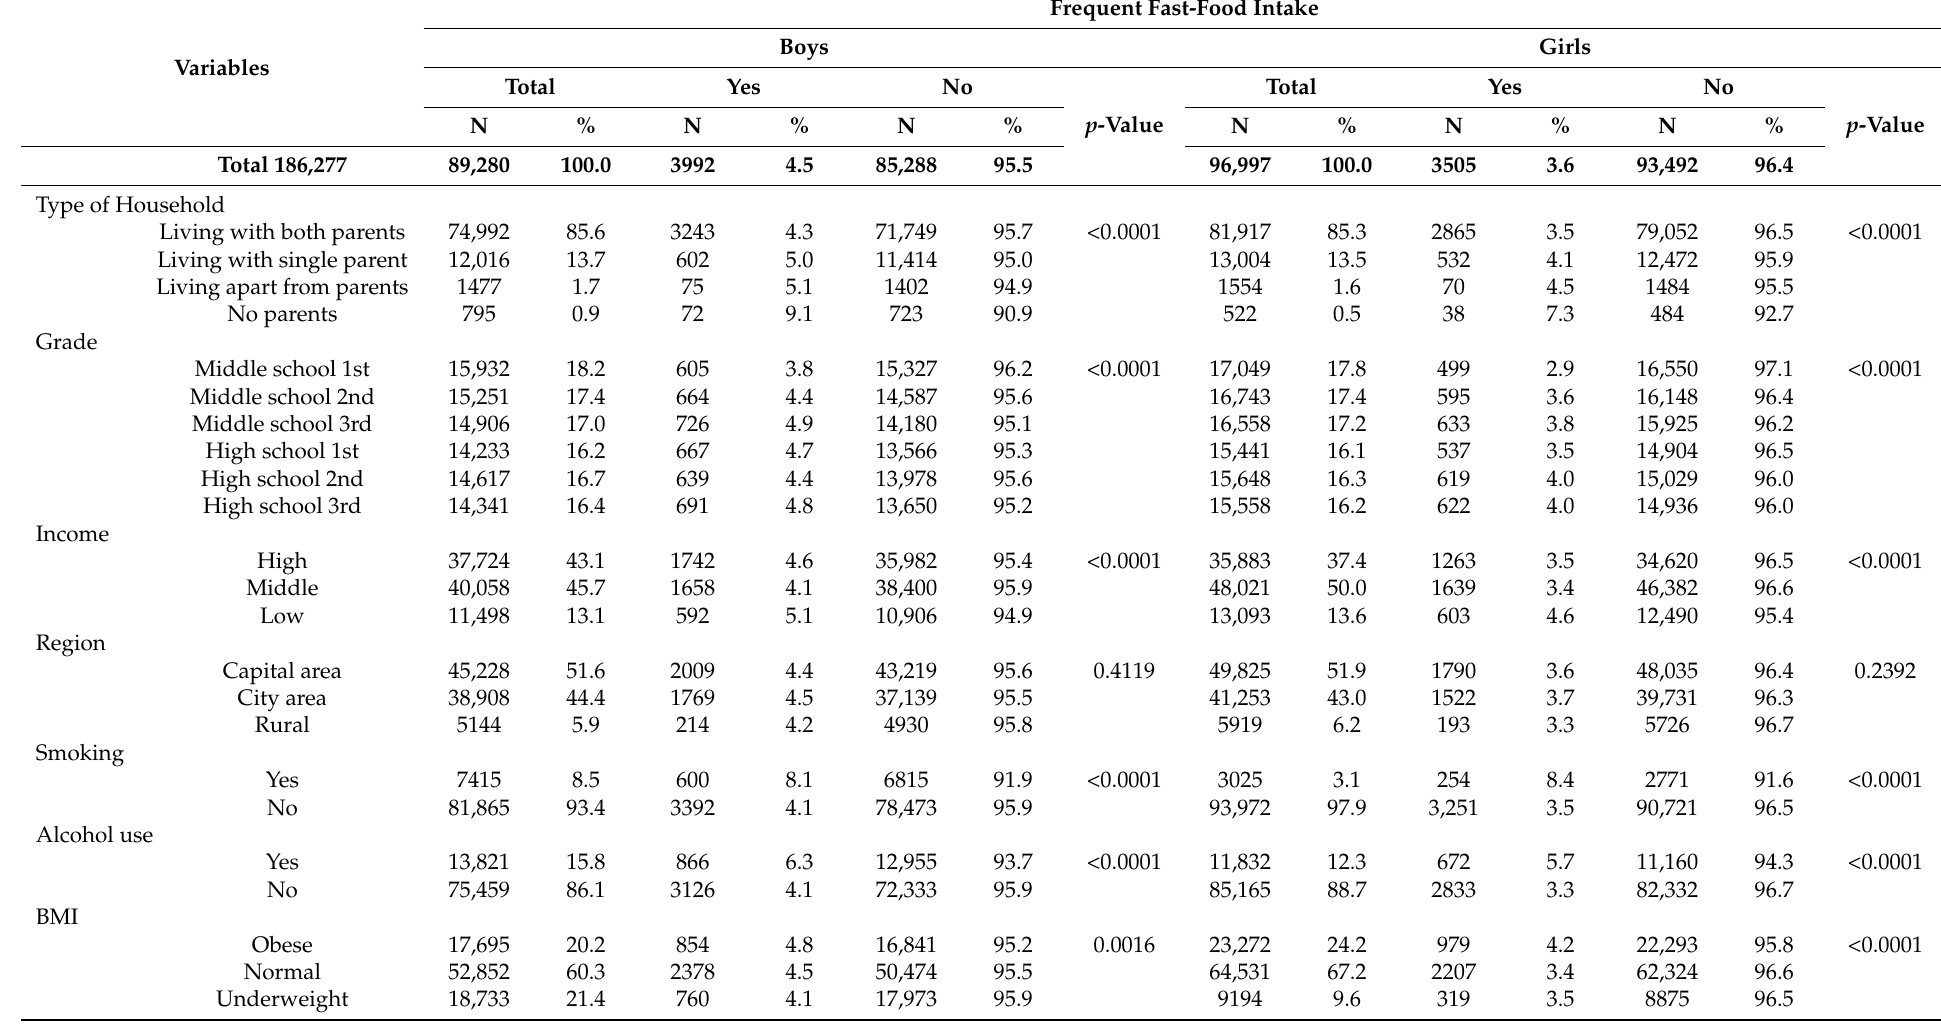
Table 1. General characteristics of the study